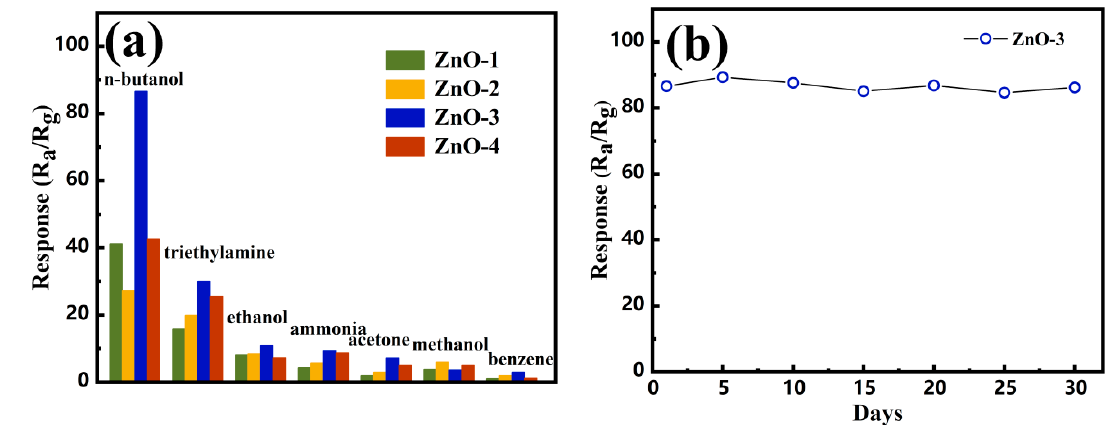
Figure 7. ( a ) Selectivity and ( b ) long-term stability of ZnO hollow microspheres.